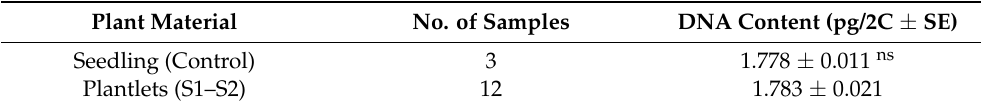
Table 6. The nuclear DNA content in leaves of Linnaea borealis var. borealis obtained from seedlings and micropropagated